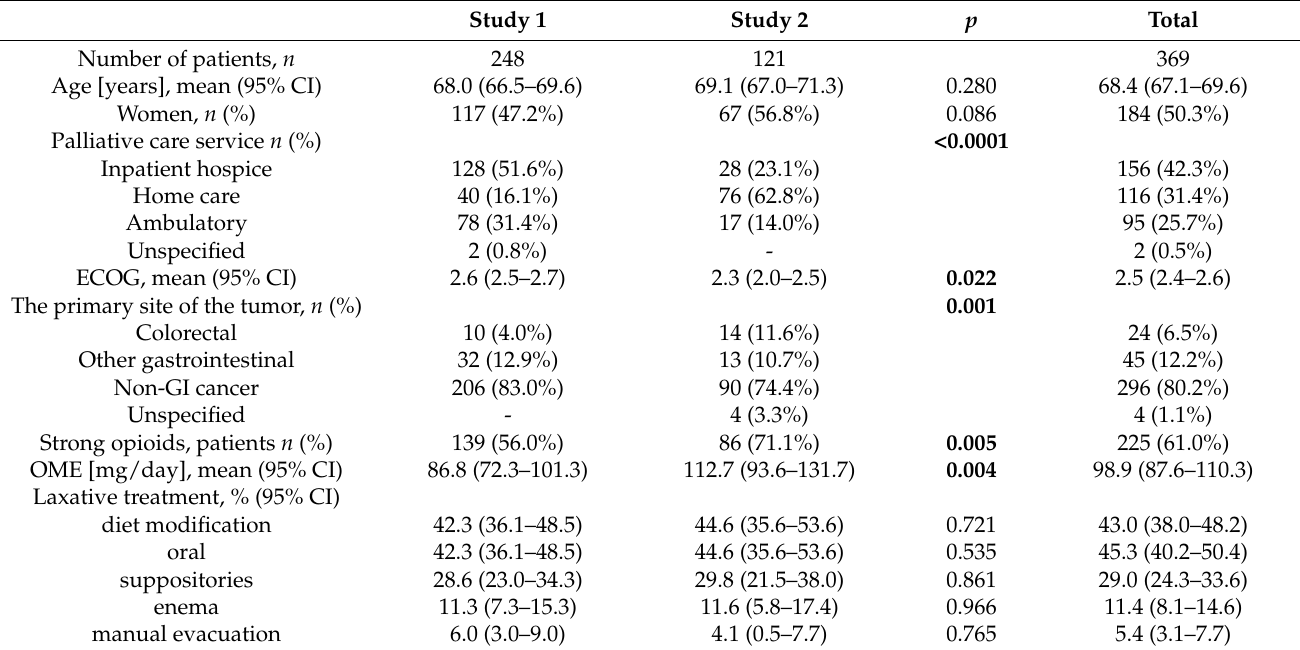
Table 1. Patient Demographics and Baseline